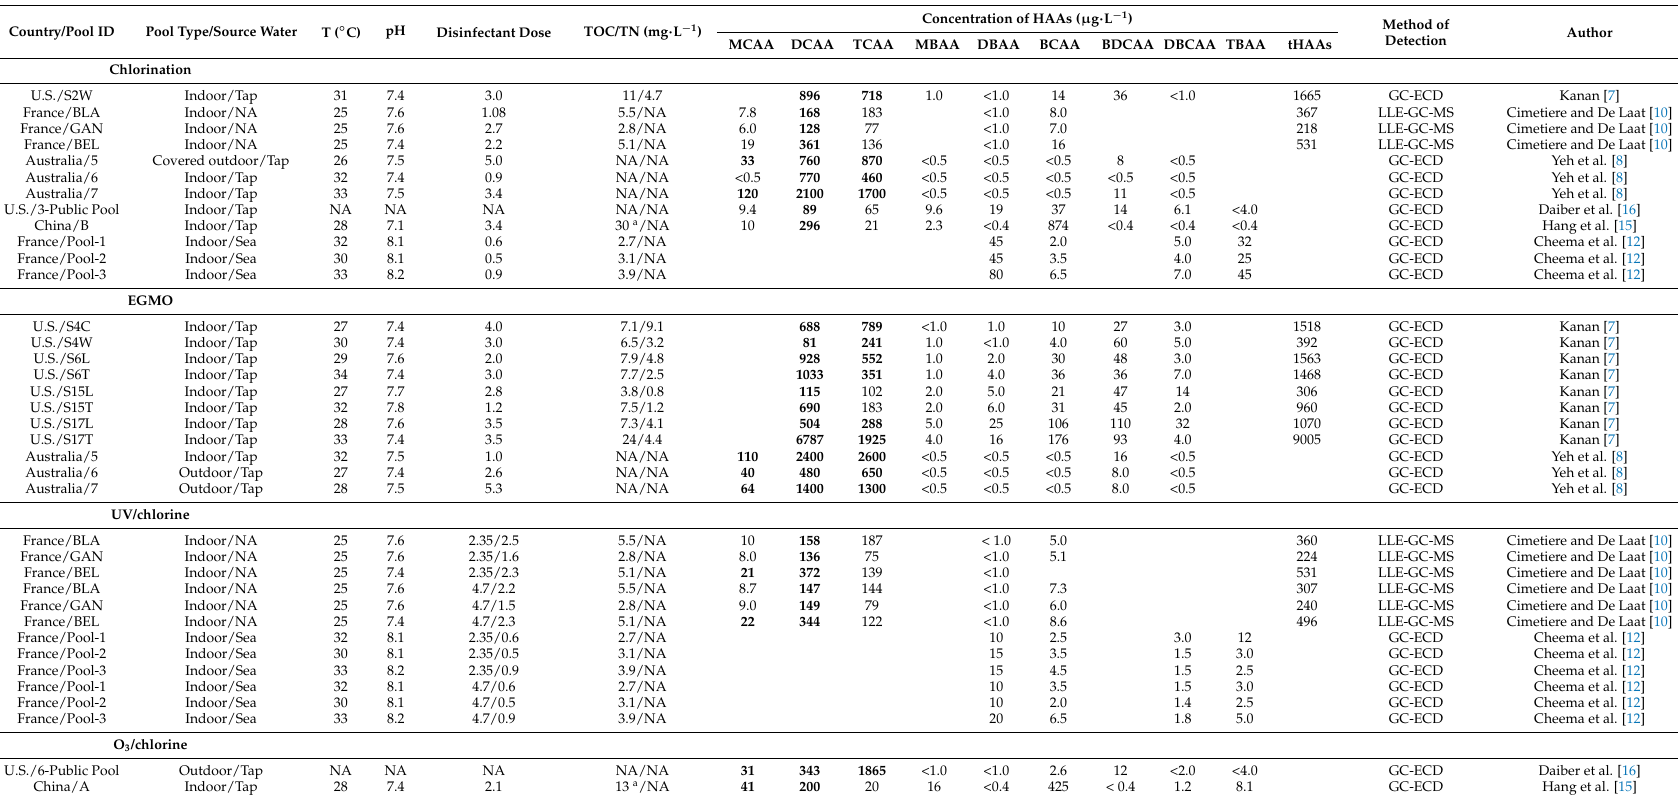
Table A4. Concentration of HAAs with different methods of